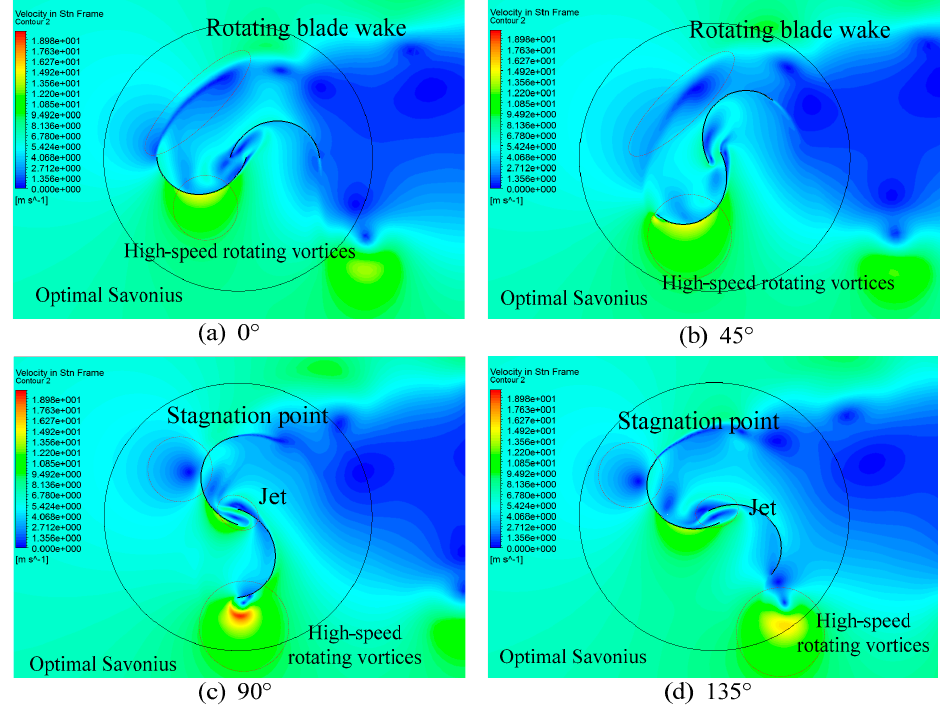
Figure 17. Velocity distributions of the local flow at different rotors angular positions for the optimal Savonius.